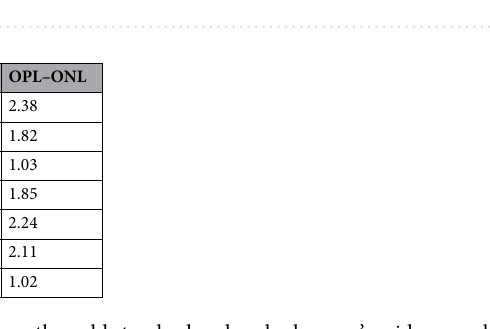
Figure 5. A representation of three segmented boundaries by each grader in the ( a ) semi-automatic mode, ( b ) grid-manual mode.